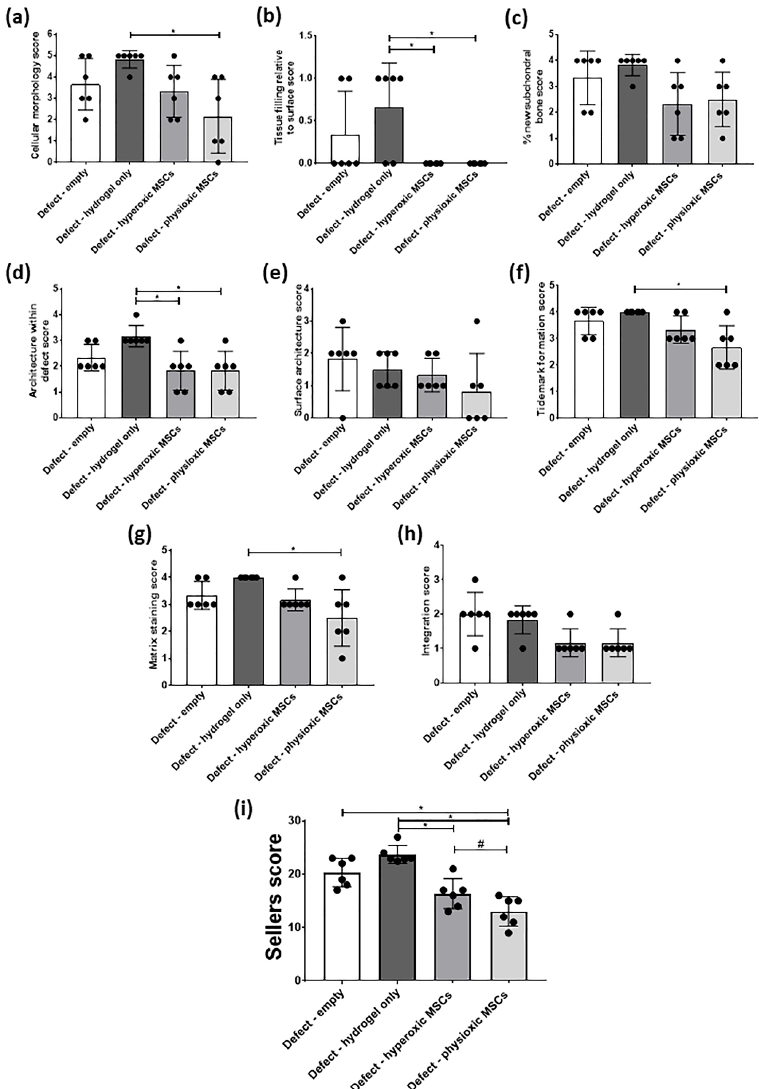
Figure 8. Individual scoring parameters of the Sellers score for ( a ) cellular morphology, ( b ) tissue filling, ( c ) % new subchondral bone, ( d ) architecture within the defect, ( e ) surface architecture, ( f ) new tidemark formation ( g ) new cartilage matrix staining and ( h ) cartilage integration with surrounding cartilage between groups in the post-trauma model. * p < 0.05 from Kruskal-Wallis test with Dunn’s multiple comparison test. ( i ) The overall Sellers score for cartilage repair in a post trauma model). * p < 0.05 from one way ANOVA with Tukey post-hoc test, # p < 0.05 from pairwise t-test. Data represent the mean ± S.D. of n = 6 rabbits with dots representing the mean from three blinded scorers (five sections per defect).